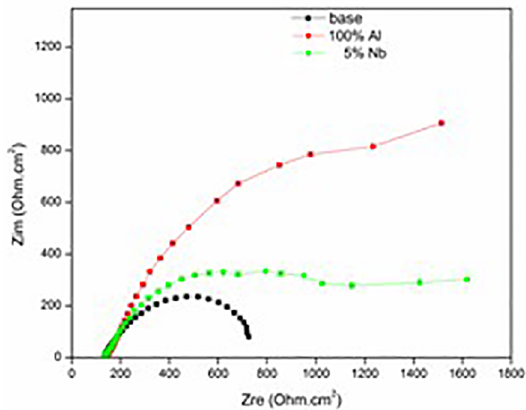
Figure 8. Nyquist representation For comparison, Fig. 9 shows the polarization curves